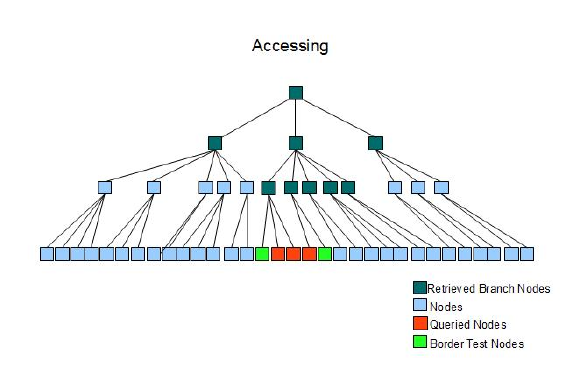
Fig. 3. Verification Tree